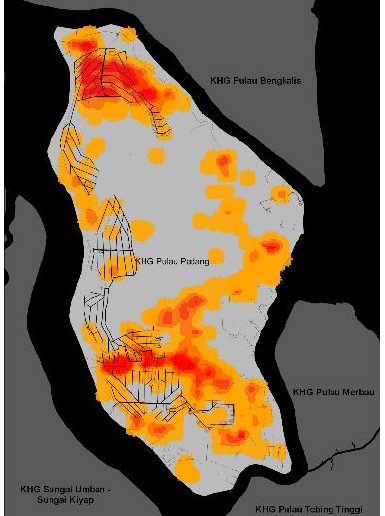
Figure 2. Heatmap of hotspots from 2004-2015 in Padang